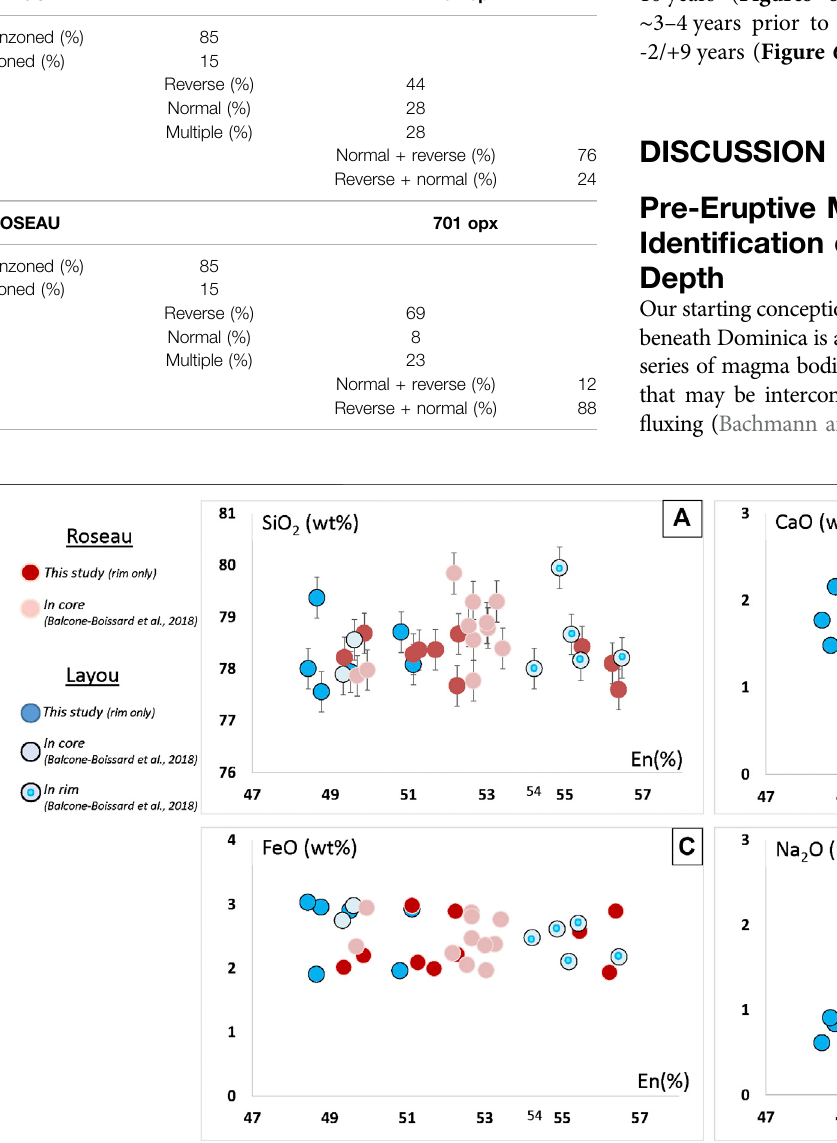
FIGURE 4 | Selected melt inclusion compositions as a function of host-orthopyroxene composition (En mol%). (A) SiO 2 ; (B) CaO; (C) FeO; (D) Na 2 O.